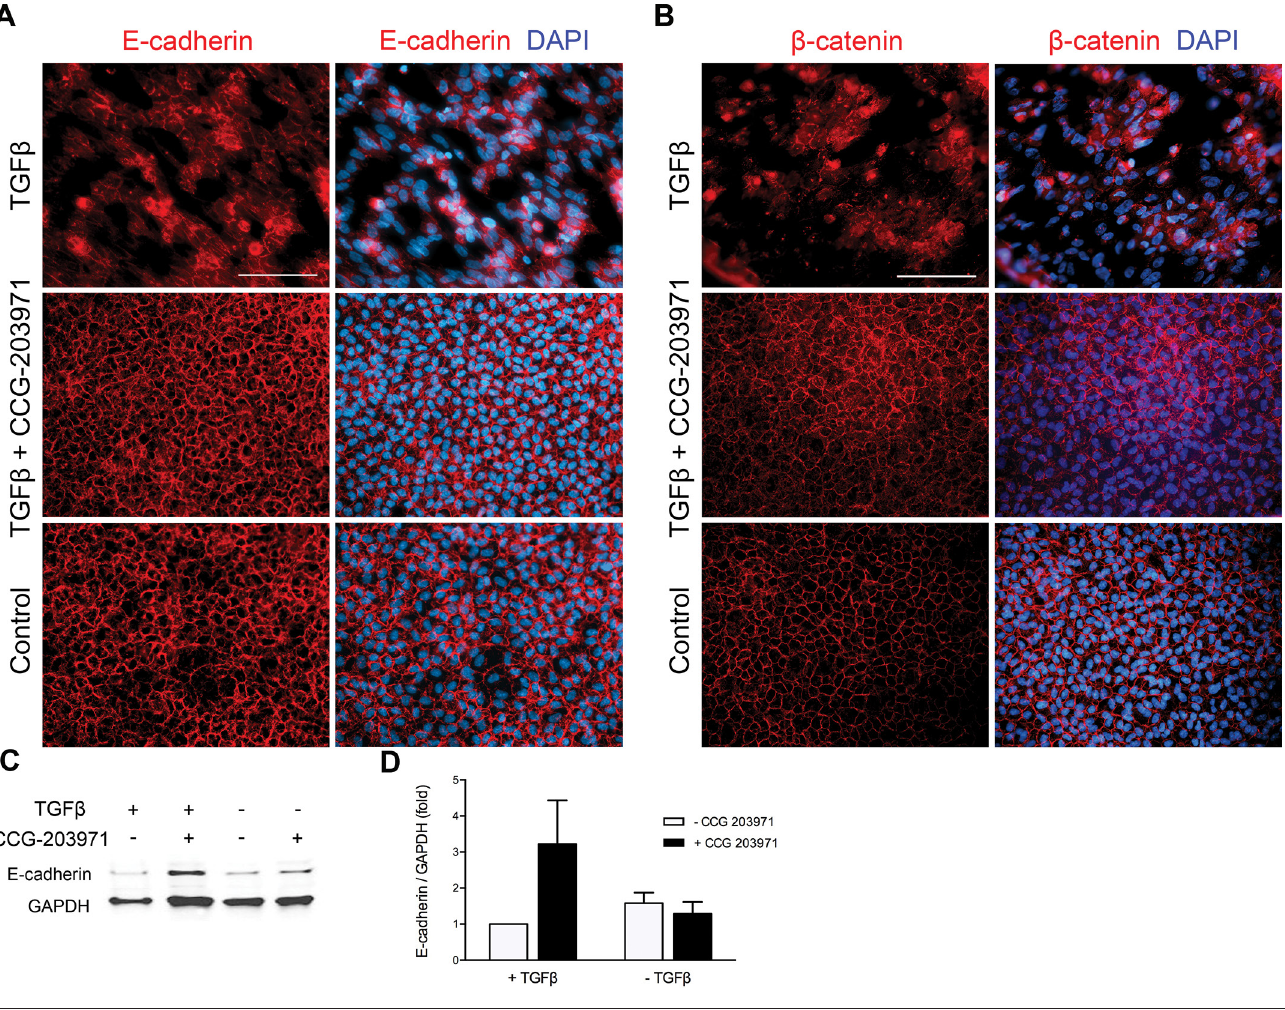
Figure 7. CCG-203971 prevents TGF β -induced E-cadherin and β -catenin delocalization from the cell membrane. Lens explants (n ≥ 5 per treatment) were fixed and costained for (A) E-cadherin and α SMA or (B) β -catenin and α SMA following TGF β (4 ng/mL) treatment in the presence and absence of CCG-203971 (5 μ M) after 48 h. All explants were mounted in medium with DAPI to colocalize nuclei. (C) Pooled lens explant lysates (n ≥ 5 explants per sample) were probed for the cytoplasmic domain of E-cadherin and GAPDH as loading control. (D) Densitometric quantification of E-cadherin indicating the fold reduction in E-cadherin/GAPDH expression normalized to TGF β -treated explants. Data are expressed as means ± SEM from three separate experiments. Scale bar = 100 μ m